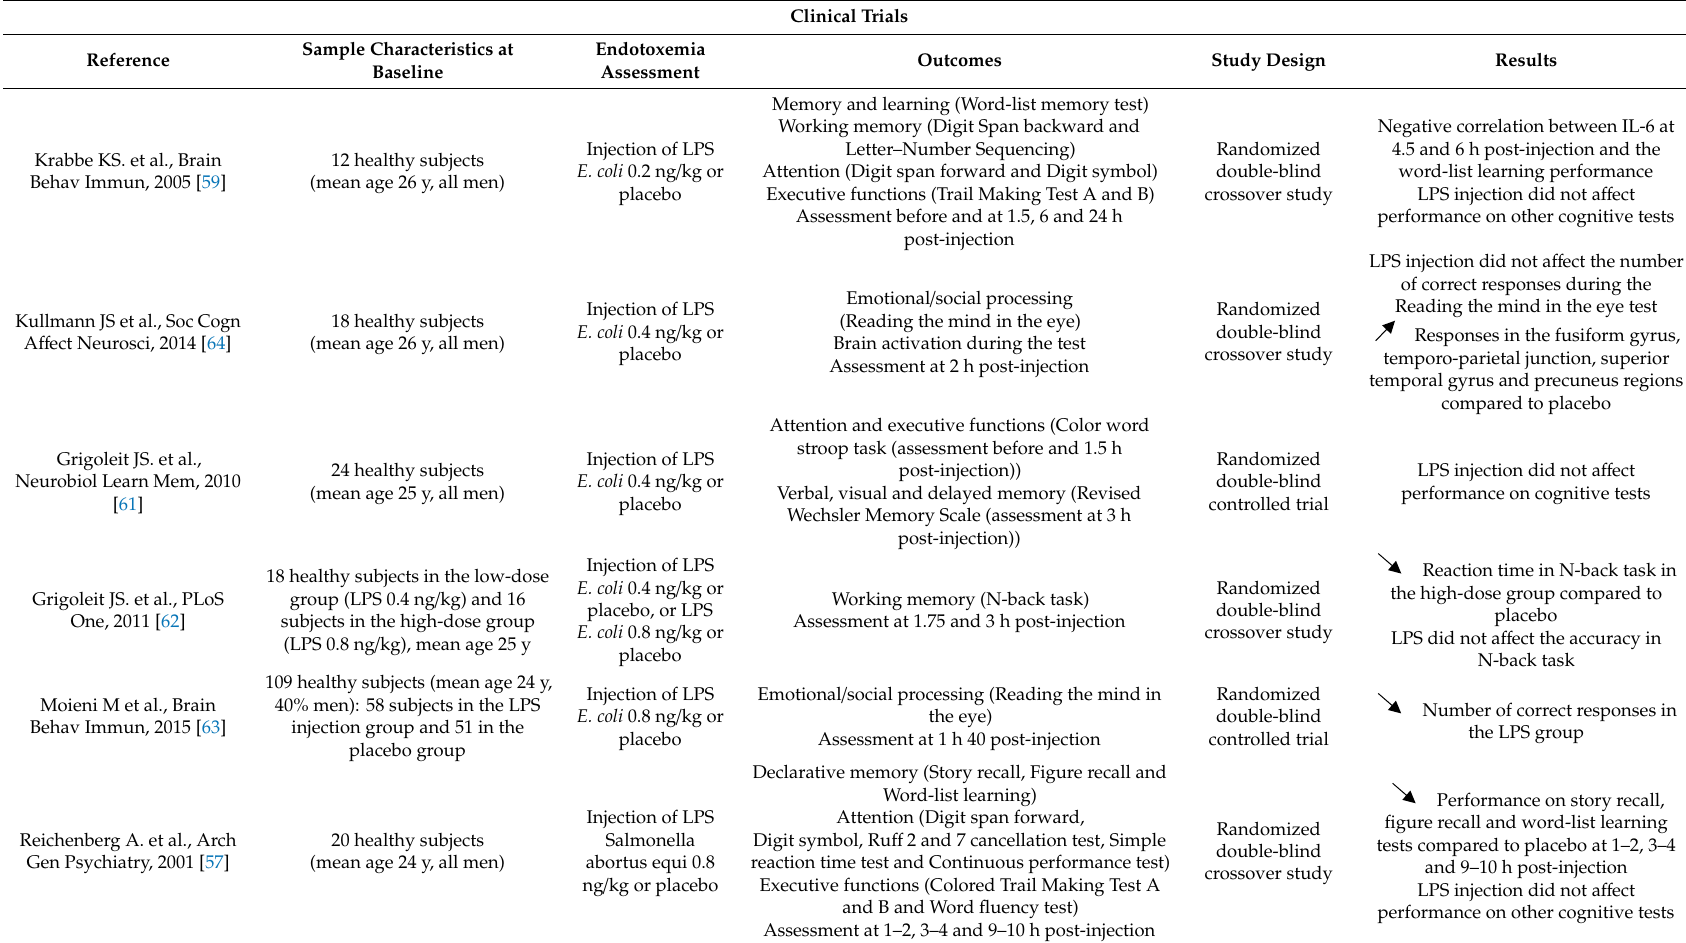
Table 3. Selective evidence on the association between lipopolysaccharides and cognitive function.